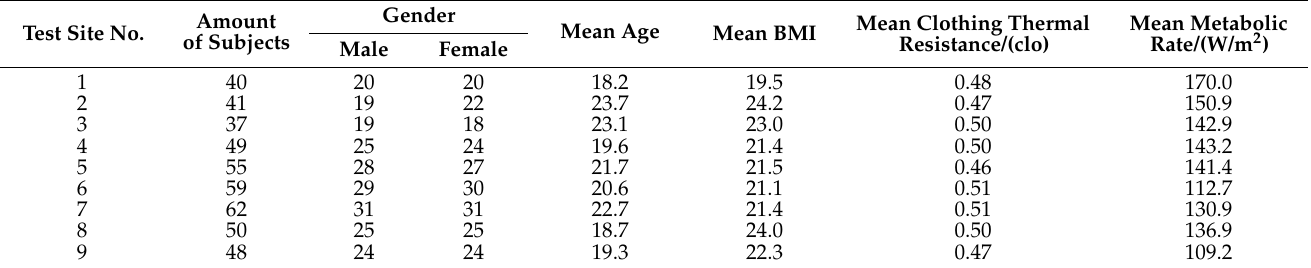
Table 4. The basic attributes of the subjects in nine different test